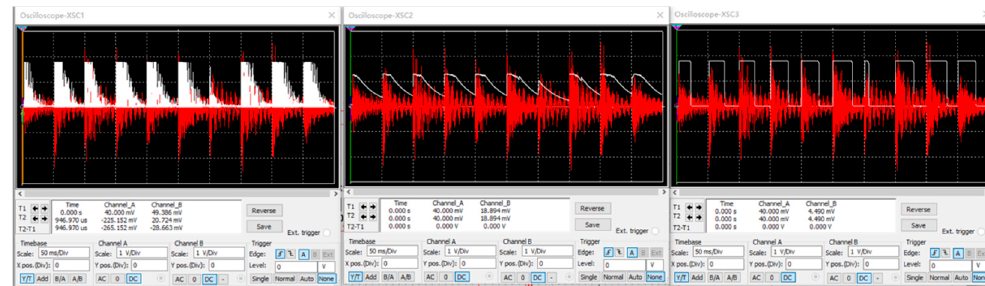
Figure 7. Change process of grain signal.